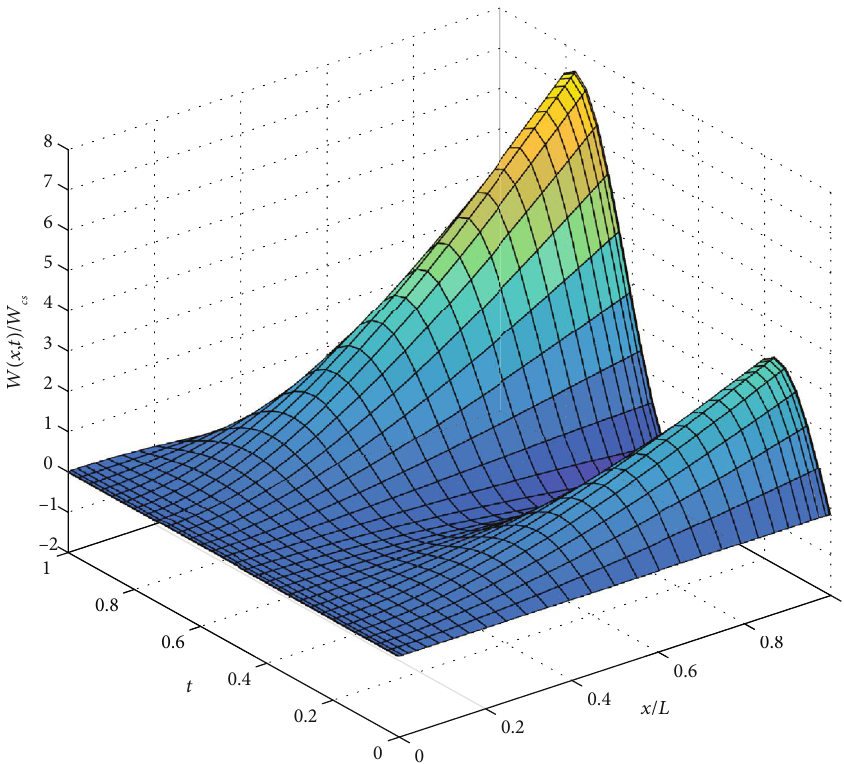
Figure 13: Numerical results 3D for normalized de fl ection of C-F beam excited by three actuators with excitation harmonic di ff